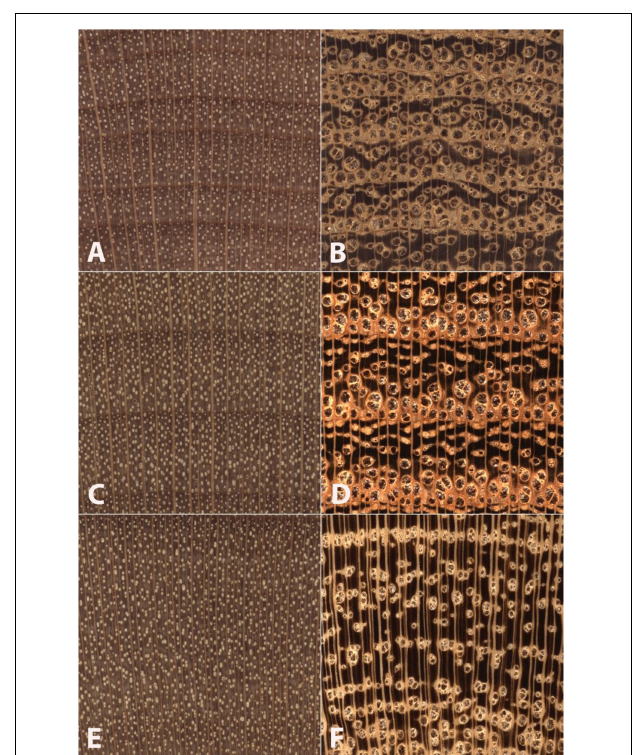
FIGURE 1 | Images of transverse surfaces of Betula alleghaniensis (A,C,E) and Robinia pseudoacacia (B,D,F) showing similar slow-growth conditions (A,B) medium-growth conditions (C,D) , and faster-growth conditions (E,F) . Note that Betula alleghaniensis shows comparatively lesser wood anatomical spatial heterogeneity than Robinia pseudoacacia . The nearly three complete growth rings in panels (C,D) present wood anatomical detail sufficient to facilitate an identification. The slow growth in panels (A,B) and partial growth rings in panels (E,F) demonstrate the comparatively lesser spatial heterogeneity of the diffuse porous Betula alleghaniensis . In Robinia pseudoacaia there is a lack of latewood characters in the slow-grown image (B) , and only latewood anatomy in panel (F) . By contrast, Betula alleghaniensis shows substantially similar anatomy across the three images (A,C,E)